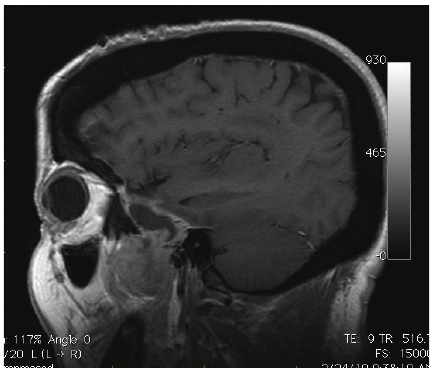
Figure 10: Postoperative (24 hr) follow-up T1-WI parasagittal MRI demonstrates complete resection of tumor from the infratemporal region.